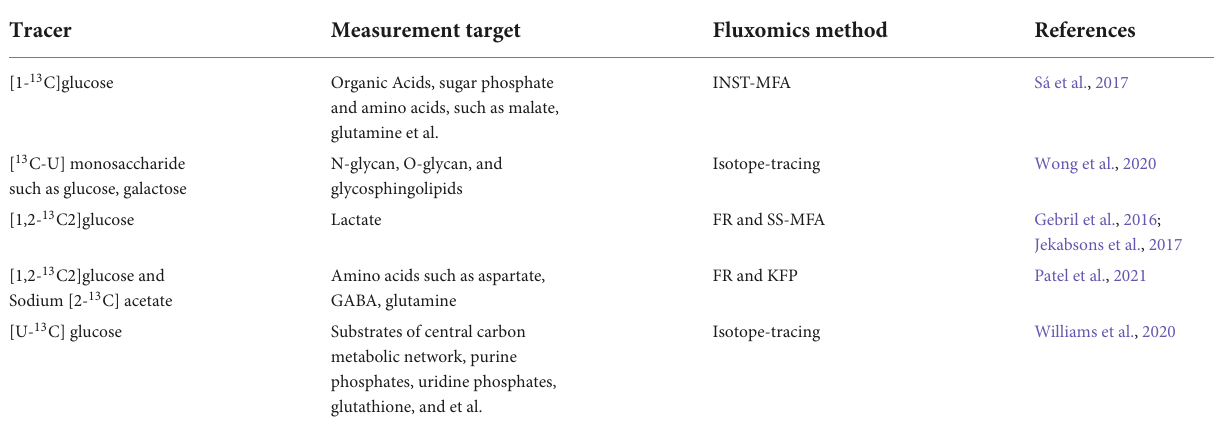
TABLE 3 Outline of neural cell studies using fluxomics